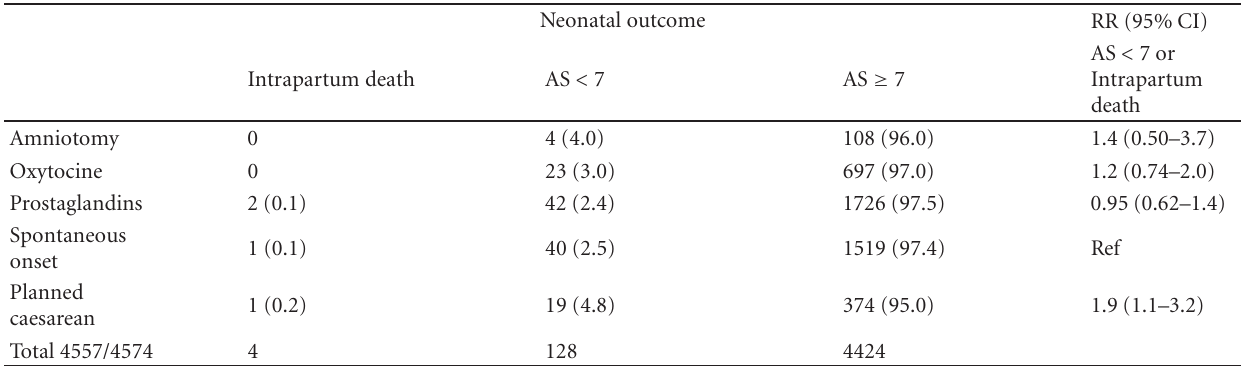
Table 4: Neonatal condition after birth in pregnancies complicated by SGA and hypertensive disorders (with or without